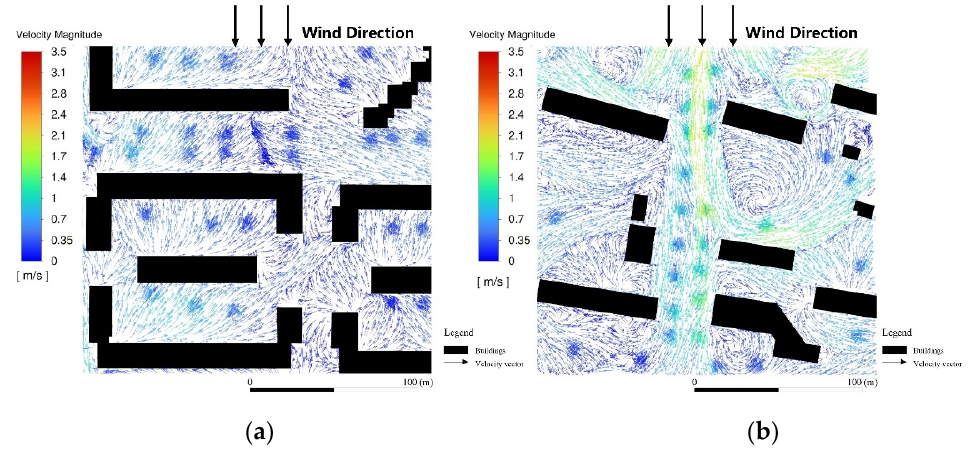
Figure 9. Vector diagram of local wind speed in: ( a ) Neighborhood A; ( b ) Neighborhood B.